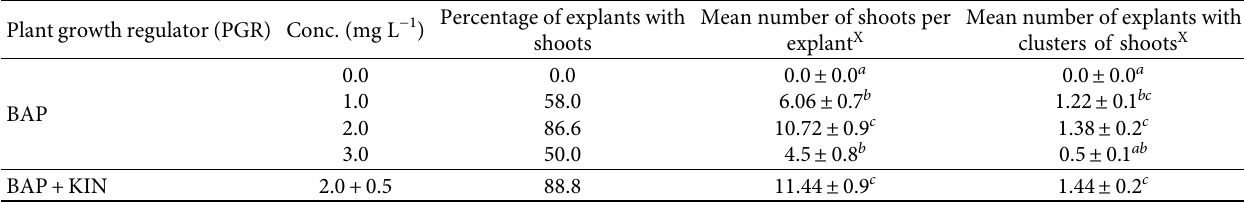
Table 1: Effect of BAP and KIN on in vitro shoot induction from leaf disc explants of KPF 4 passion fruit variety after 8 weeks of culture.